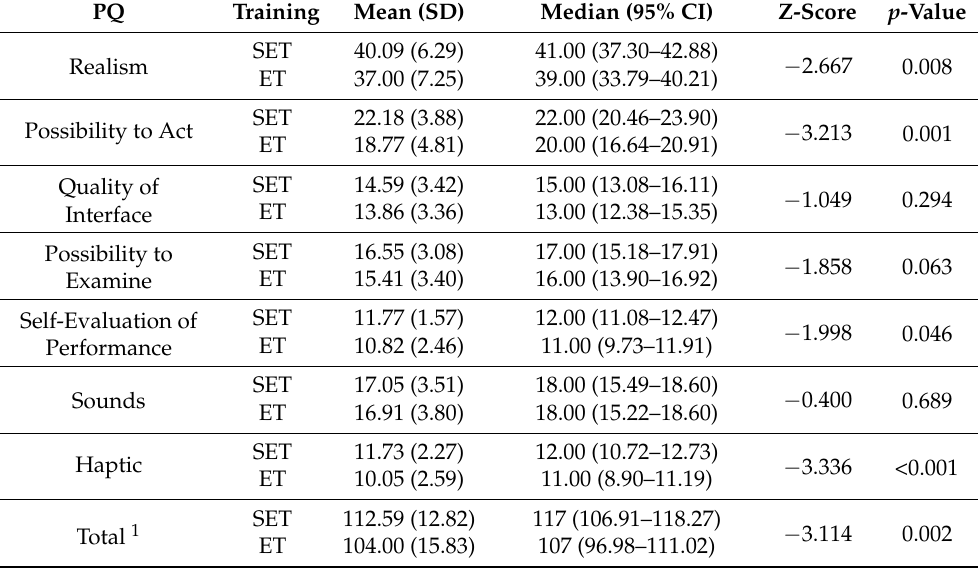
Table 3. Results of the presence questionnaire (PQ) for the strength endurance training (SET) and endurance training